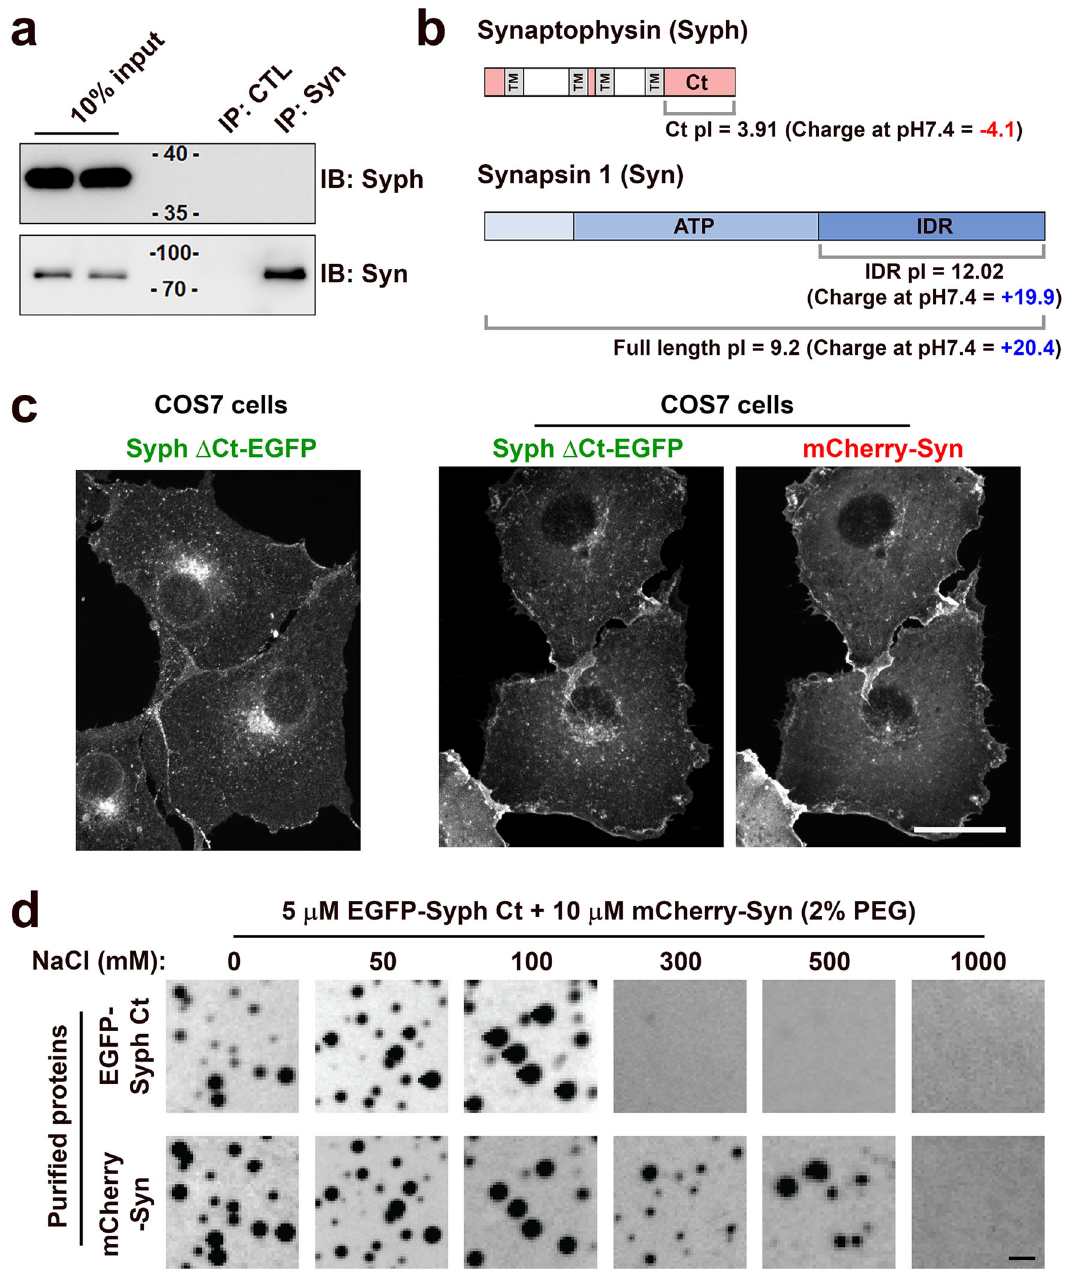
Fig. 6 Electrostatic interaction between synapsin and the cytosolic domain of synaptophysin (Syph Ct) contribute to the clustering of the vesicles via phase separation. a Western blots of starting lysates and pellets of immunoprecipitations (IP) from DIV15 cultured hippocampal neurons. Anti- synaptophysin or anti-synapsin antibodies were used for immunoblotting (IB). b Domain structures of synaptophysin and synapsin and pIs (isoelectric points) values of human and mouse Syph Ct and human full-length synapsin. c EGFP-tagged C-terminal deletion mutant of synaptophysin (Syph Δ Ct-EGFP, 1-218 a.a) was expressed alone or with mCherry-synapsin. d Co-assembly of the two puri fi ed proteins in vitro. 5 μ M EGFP-Syph Ct and 10 μ M mCherry- synapsin were mixed in a buffer containing 25 mM Tris-HCl (pH 7.4), 0.5 mM TCEP, 2% PEG and supplemented with NaCl of various concentrations (from 0 to 1 M). Increasing the concentration of NaCl results fi rst in the dissociation of Syph Ct and then also in the dispersion of synapsin. Scale bars, c = 20 μ m, d = 1 μ mouse brains and placed in ice-cold HBSS. Tissues were then digested for 20min in a HBSS solution containing papain (20U/ml) and DNase (20 μ g/ml) at 37°C. After trituration, dissociated cells were plated onto poly-d-lysine-coated coverslips to a density of 12,000 – 20,000cells/cm 2 . Three hours after plating, the plating medium was in serum/antibiotics free medium (DMEM) for 3h at 37°C in a CO 2 incubator. The exchanged to neurobasal medium containing 2% B-27 and 0.5mM L-glutamine. Cells were maintained at 37°C in a 5% CO 2 humidi fi ed incubator. 30% of cultured medium was replaced by growth medium and cells were further incubated for 18 – 36h before imaging. Hippocampal neurons were cultured, transfected at 8 days in vitro medium was replaced with new complete neurobasal medium at DIV4, 7 and 14. For using a calcium phosphate transfection method as previously described 30 , and fi xed at calcium phosphate transfection, 6 μ g of plasmid DNA and 9.3 μ l of 2M CaCl 2 were 18 days in vitro. Brie fl y, hippocampus was dissected out from postnatal day 0 (P0) gently mixed with distilled water (Final volume: 75 μ l) and added to the equal volume of